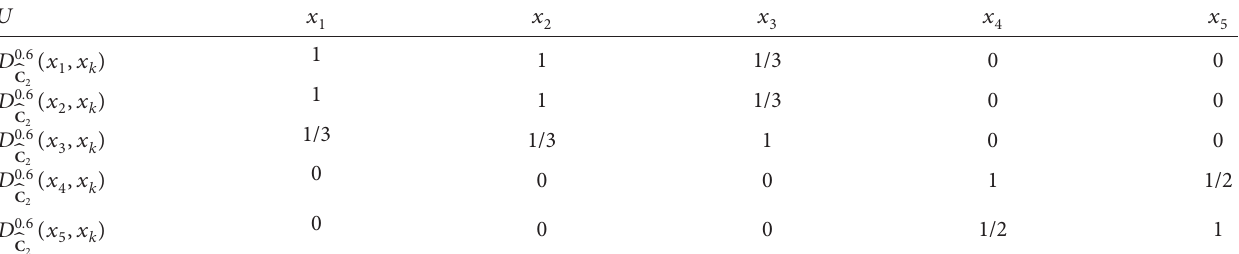
( x , x )( j,k � 1 , 2 , . .. , 5 ) 􏽢 j k C 2